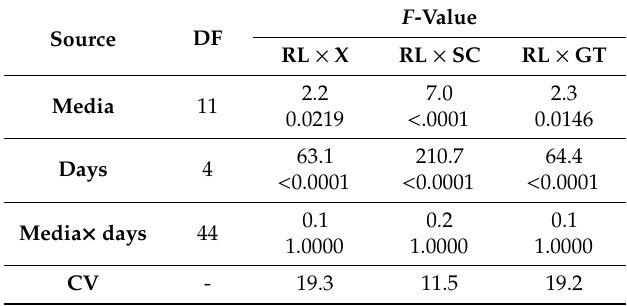
Table 5. Analysis of variance of germination of embryos from three di ff erent crosses at 65, 80, 95, 110, and 125 days after pollination (DAP) on 12 di ff erent media